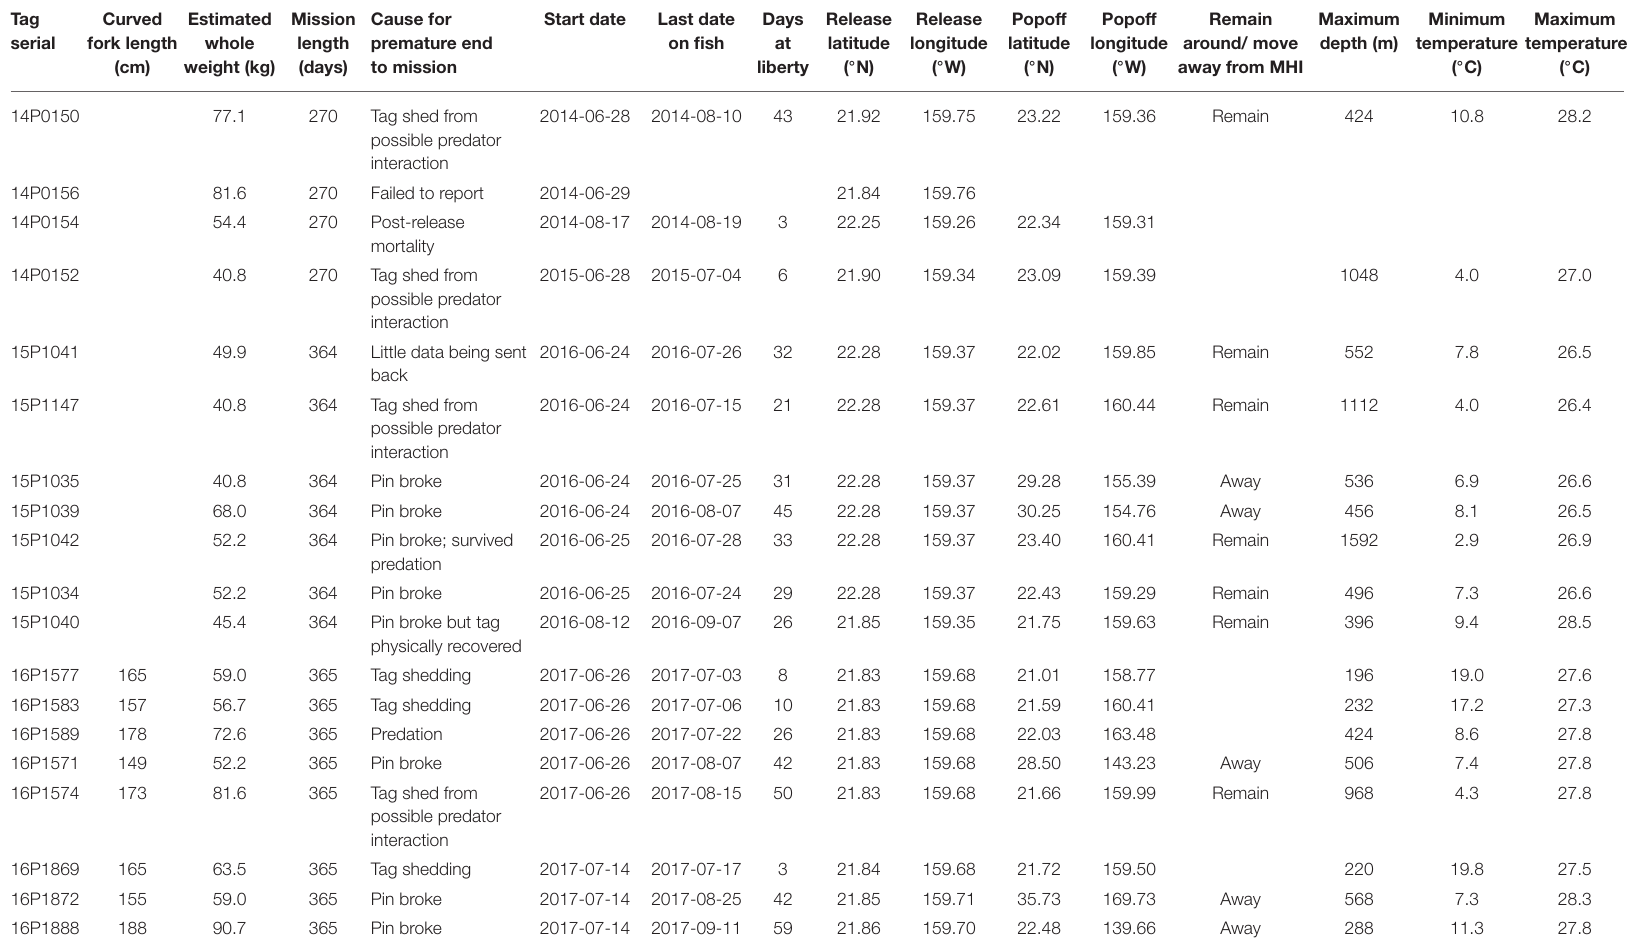
TABLE 1 | Tagging and data summary for adult yellowfin tuna, Thunnus albacares . Tag